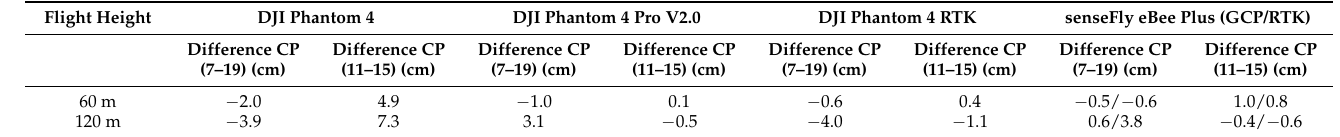
Table 9. Calculated distance differences between point pairs 7 and 19, and 11 and